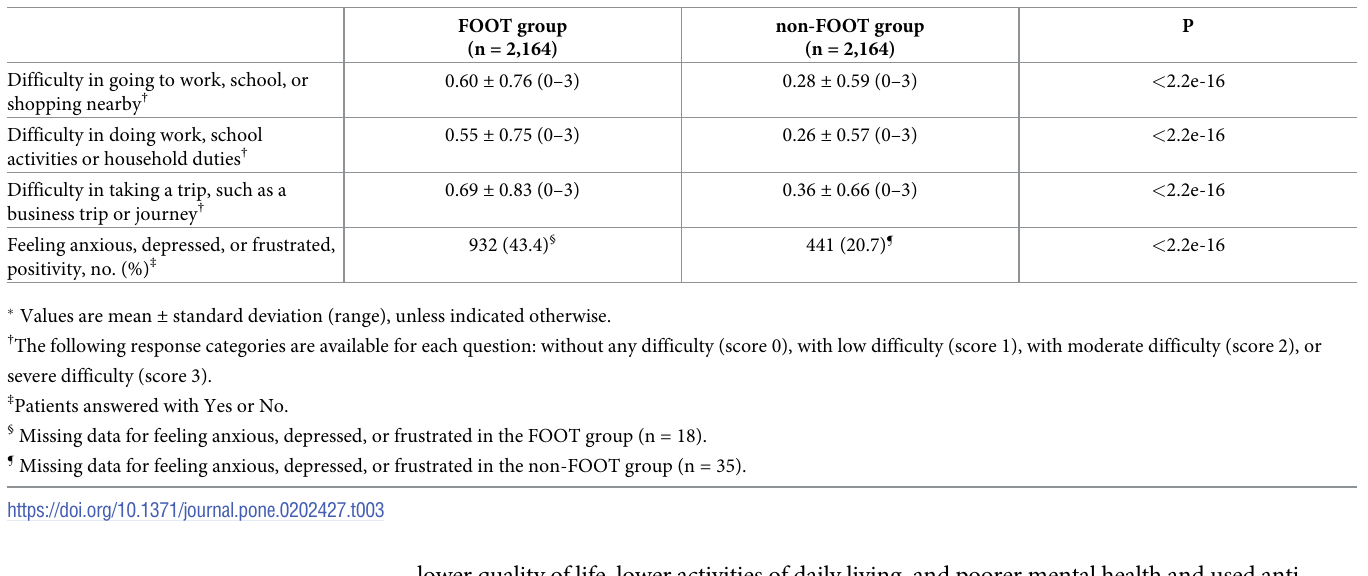
Table 3. Comparison of daily living activities and mental health in the IORRA survey conducted in April 2016 between the patients whose debut joint was the foot or ankle (FOOT group) and patients whose debut joint was another joint (non-FOOT group).